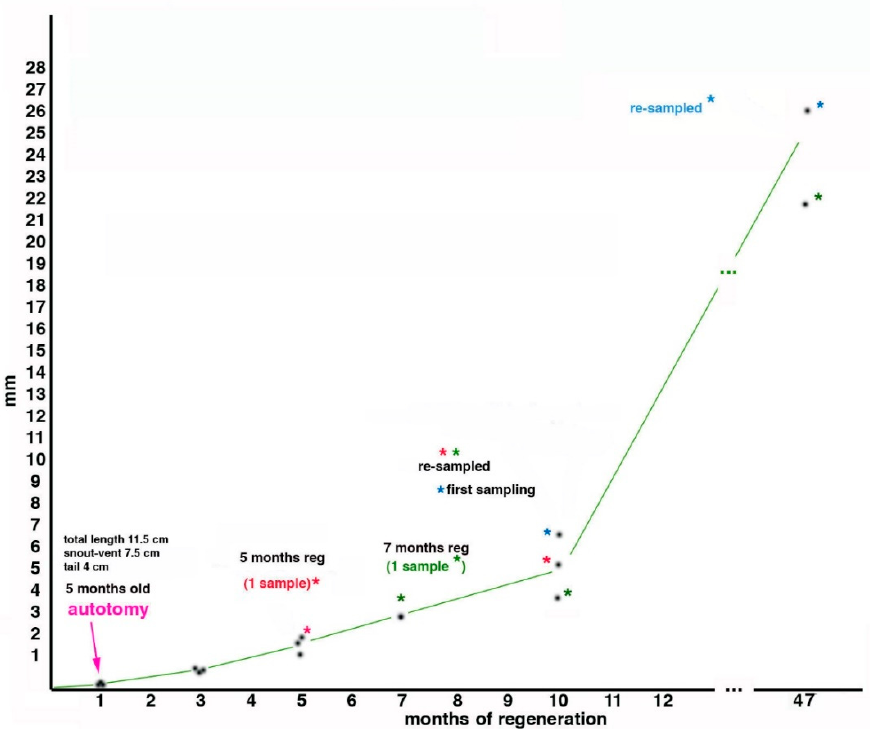
Figure 3. Growth of the regenerating tail during 47 months associated with body regeneration in three tuatara (indicated by asterisk of different coloration), received initially at 3 months of age, autotomized at 5 months of age at about half-distal length of the tail, measured and sampled at different periods thereafter (see text for further explanations). The ordinate refers to the growth of the regenerate, while the abscissa refers to